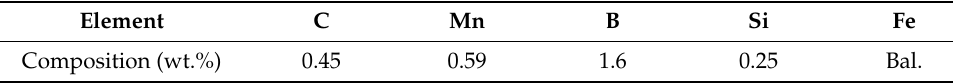
Table 1. Chemical composition of 45 steel substrate.